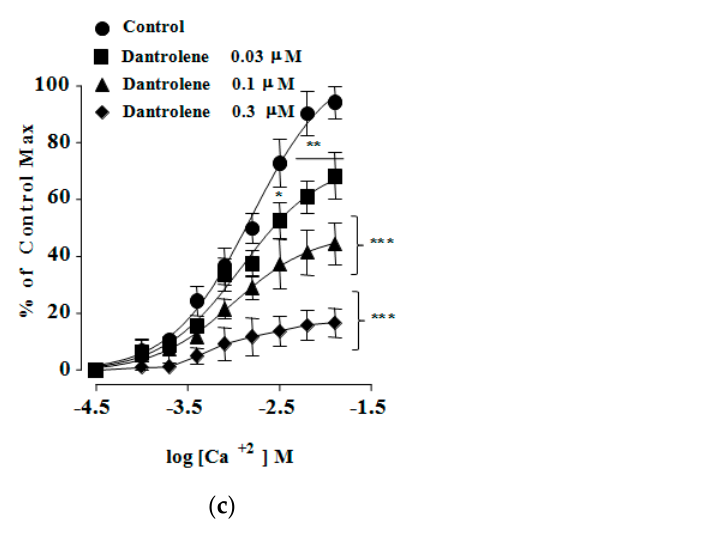
Figure 4. CRCs of Ca +2 in the absence and presence of increasing concentration of Pp.Cr (mg/mL) ( a ) verapamil (µM) ( b ) and dantrolene (µM) ( c ) on rabbit jejunum preparations. * p < 0.05, ** p < 0.01, *** p < 0.001 compared to the respective control. (Mean ± SEM, n = 3).